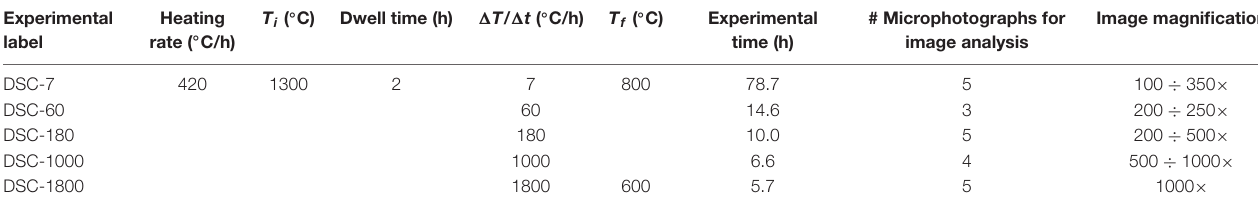
TABLE 1 | Thermal paths used for in situ DSC experiments and BS-SEM microphotographs used for image analysis. Experimental